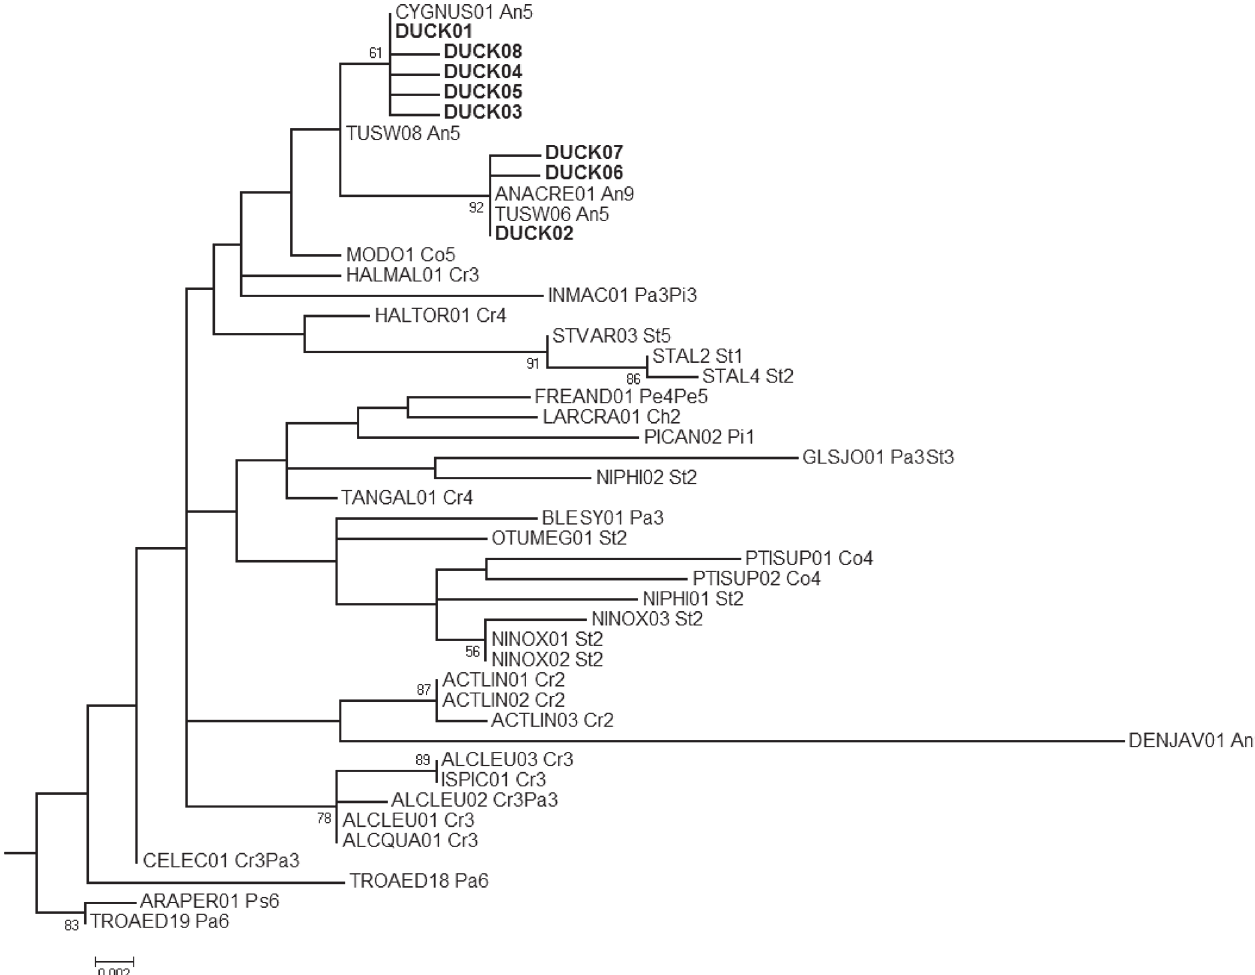
Fig 3. Haemoproteus sub-tree from a Maximum likelihood phylogenetic analysis of haemosporidian sequences constructed from 386 base pairs of the Cytochrome b gene. Bootstrap values (1,000 replicates) > 50 are shown at nodes. Haplotypes derived from Alaska and California duck samples for this study (DUCK01 – DUCK08) are shown in bold. Two-letter codes following the lineage names of MalAvi acquired sequences refer to the avian order/s reported as the host origin: Anseriformes (An), Bucerotiformes (Bu), Charadriiformes (Ch), Columbiformes (Co), Coraciiformes (Cr), Galliformes (Ga), Passeriformes (Pa), and Strigiformes (St). Numbers following the order code refer to the reported continent of origin: Europe (1), Asia (2), Africa (3) Oceania (4), North America (5), South America (6) and unknown (9).